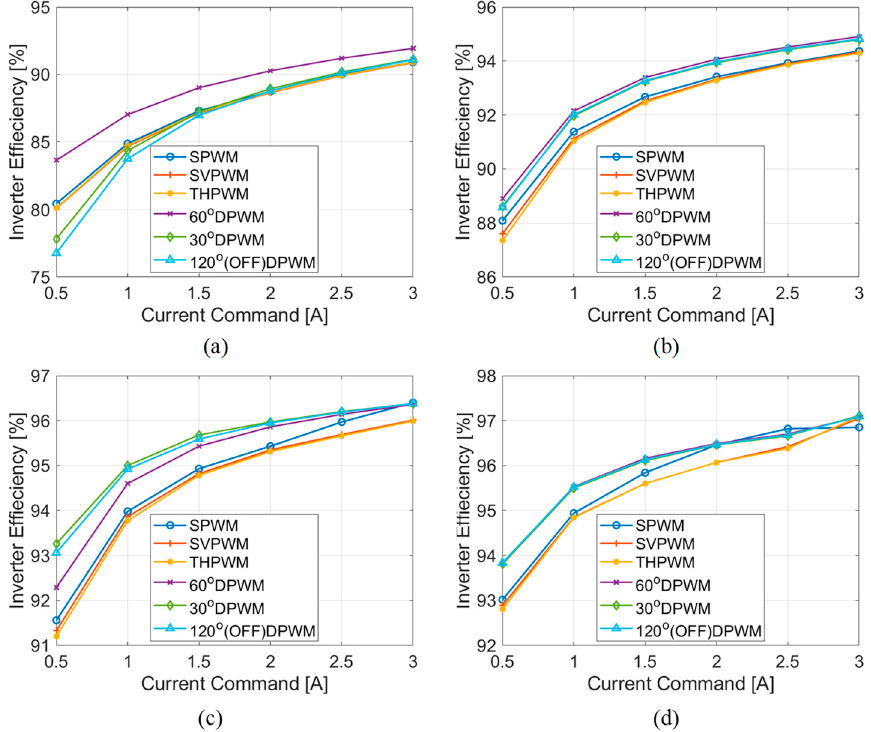
Figure 20. Experimental results of the inverter efficiency depending on the PWM technique at ( a ) 200 rpm; ( b ) 600 rpm; ( c ) 1000 rpm; ( d ) 1200 rpm.